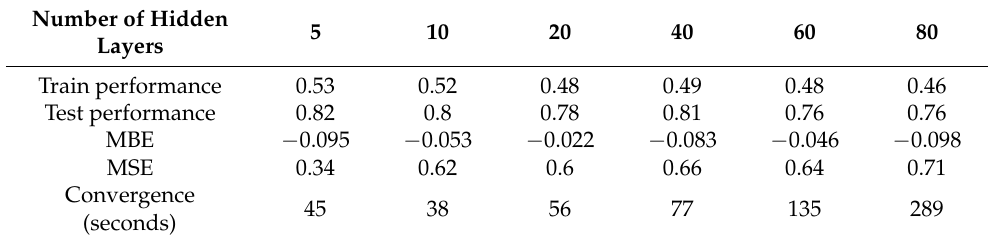
Table 8. The impact of number of hidden layers variation (in the case of the 1st network configuration). Number of Hidden